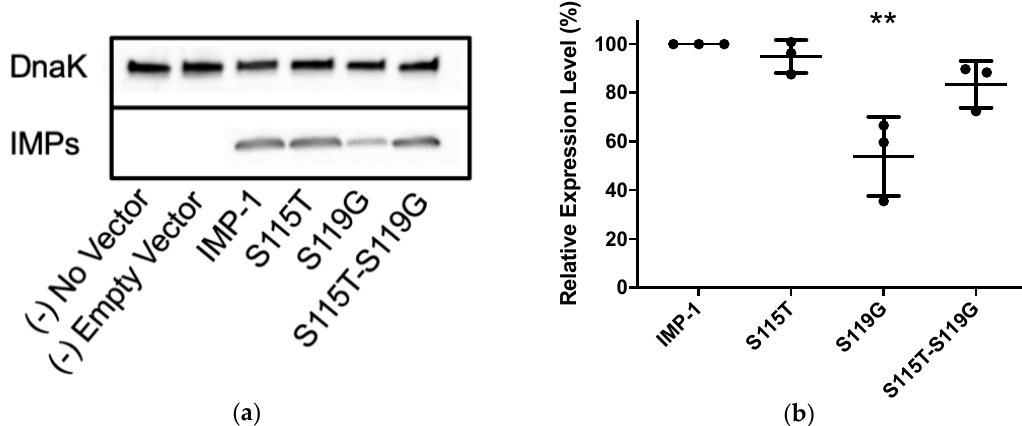
Figure 3. ( a ) Representative Western blot of the four different IMP variants expressed in E. coli DH10B cells. DnaK was used as a constitutively expressed marker. The different IMP variants were labeled with a previously reported anti-IMP-1 antibody [22,23]. Exposure times were optimized to obtain good signals without saturation. ( b ) Quantification of three different Western blot experiments. Only the expression level of IMP-1-S119G was significantly lower than that of IMP-1 ( p < 0.01). Table 2. Purification results and biophysical characteristics of purified IMP variants.